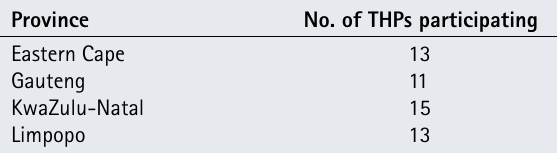
TABLE I. DISTRIBUTION OF